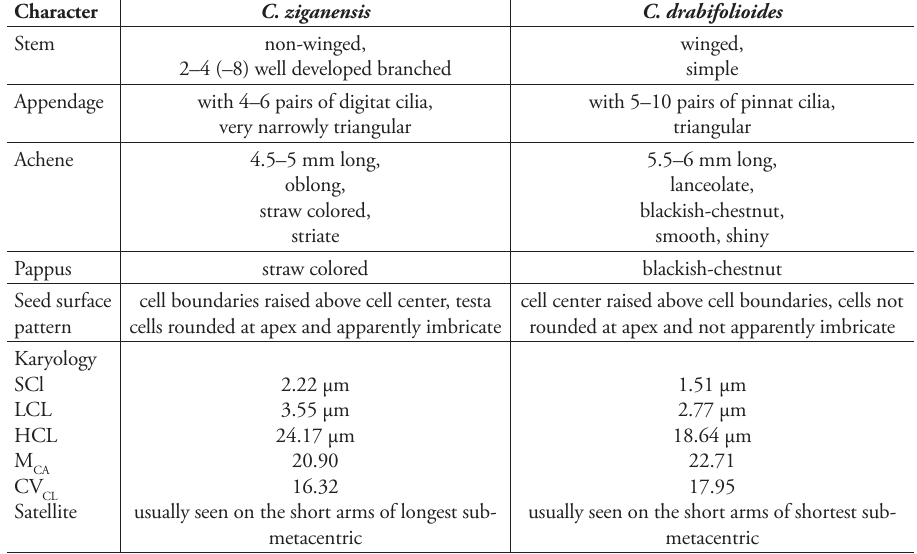
Table 1. Morphological, micromorphological and karyological comparison of Centaurea ziganensis and C. drabifolioides (Abbreviations; SCL: shortest chromosome length; LCL: longest chromosome length; HCL: haploid chromosome length; M : intrachromosomal asymmetry; CV : interchromosomal asym- CA CL metry